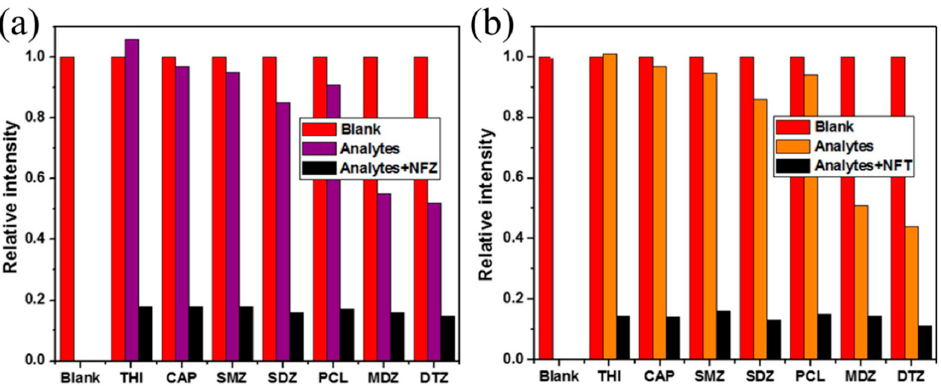
Figure 25. Fluorescent response of the Eu-BCA thin-film towards other competing antibiotics (1.0 mM) or a mixture of competing antibiotics (1.0 mM) and nitrofuran antibiotics (NFAs, 0.5 mM; ( a ) for nitrofurazone (NFZ) and ( b ) for nitrofurantoin (NFT)). Reprinted with permission from Reference [124]. Copyright 2017 WILEY-VCH Verlag GmbH & Co., (Weinheim, Germany).